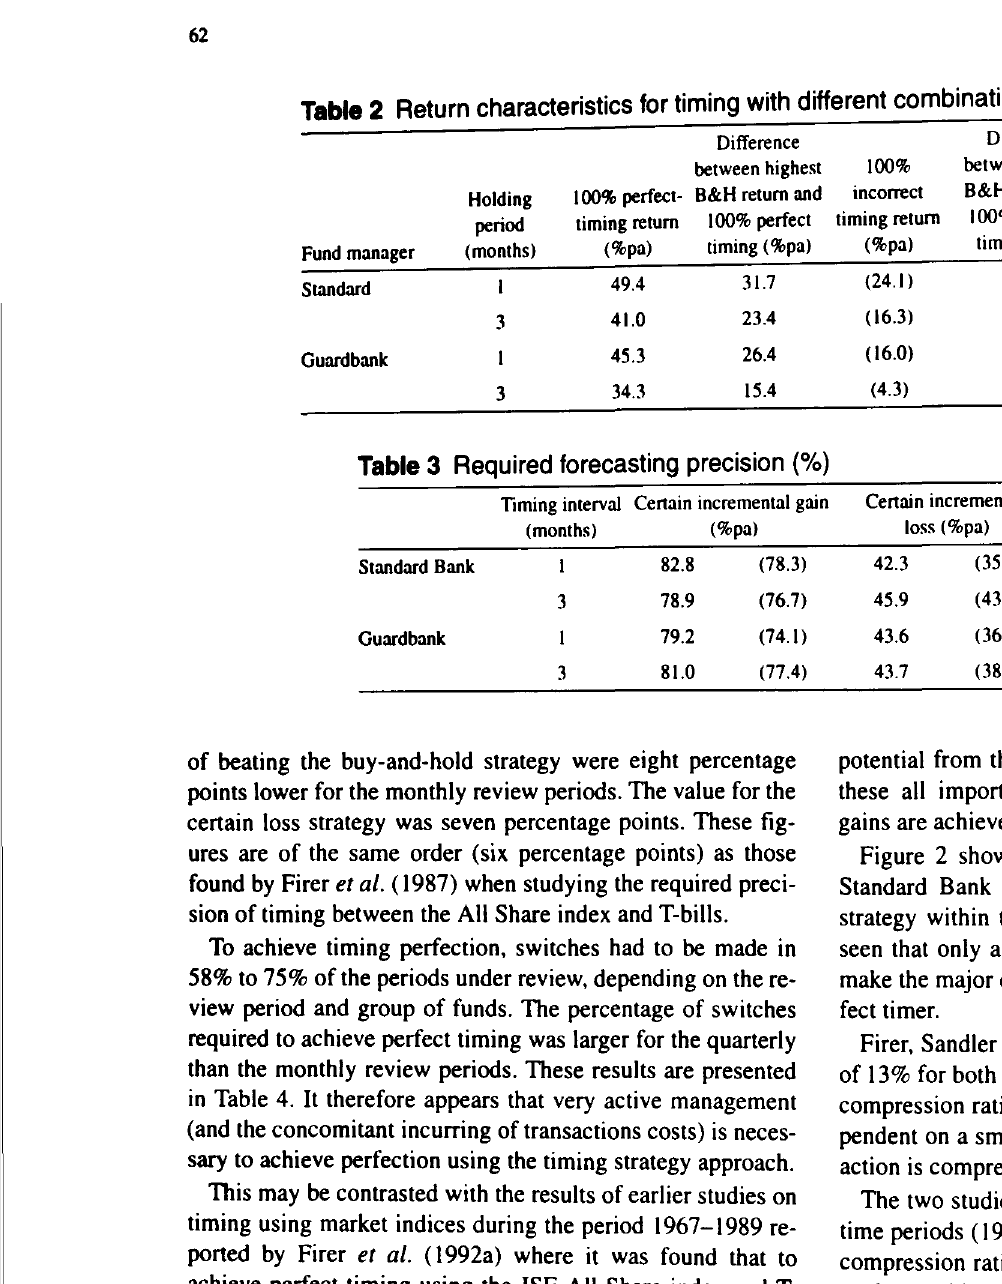
Table 2 Return characteristics for timing with different combinations of assets